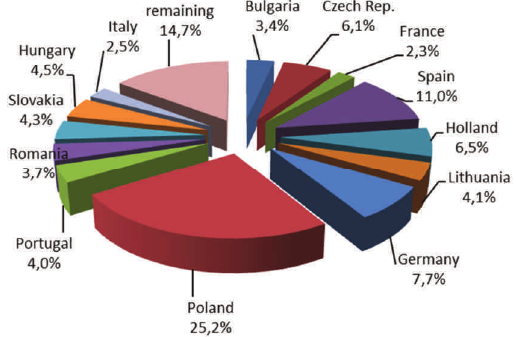
Fig. 3. Structure of international freight transport’s haulage work of the EU countries in 2014 (diagram based on CSO data [5])